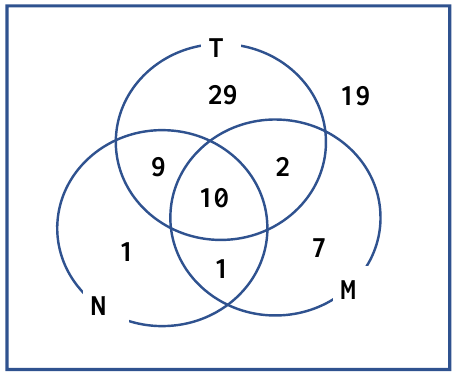
Figure 2. Failure pattern of nasal cavity or paranasal sinus tumor after reirradiation.